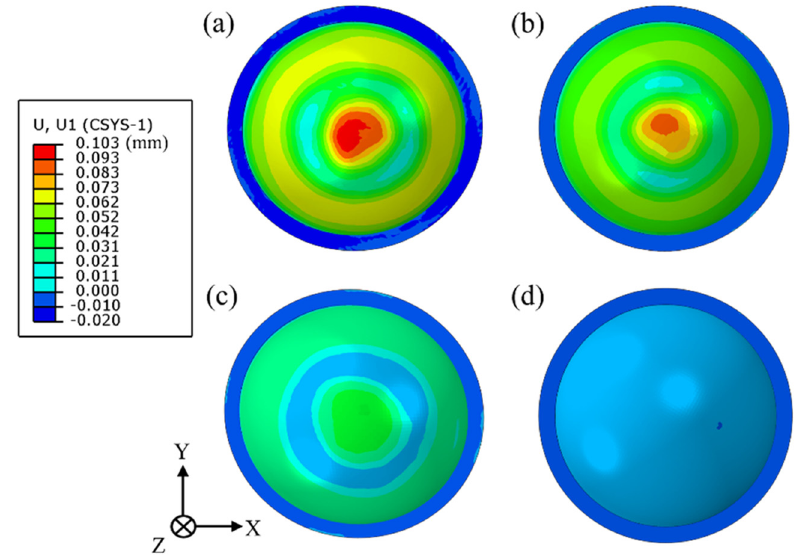
Figure 13: Simulated results of the deformation for the fi nal part with di ff erent heat treatments: ( a ) without heat treatment, ( b ) with 500°C, ( c ) 600°C, and ( d ) 650°C heat